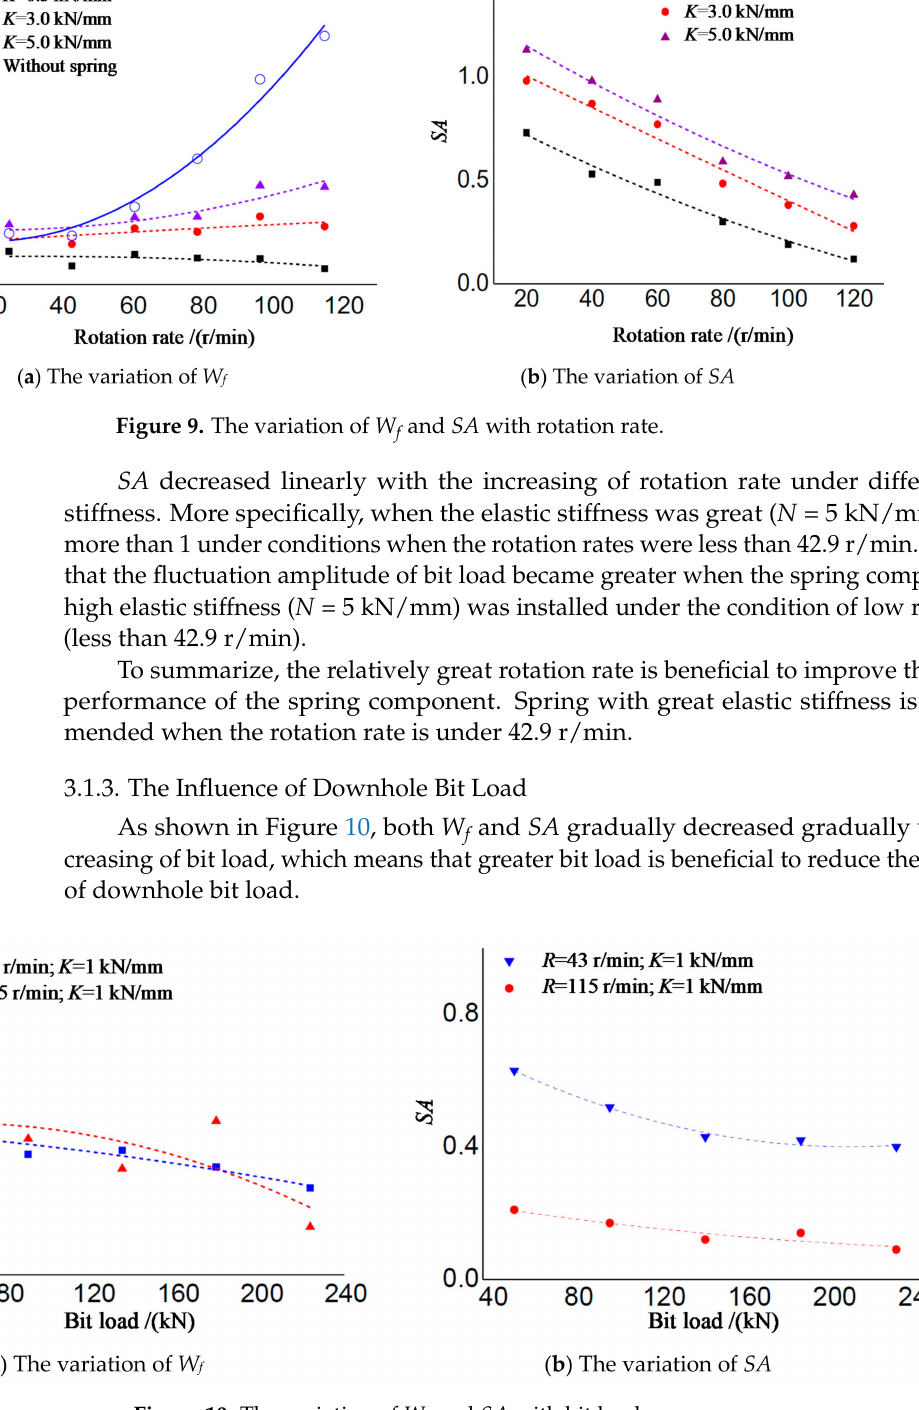
Figure 10. The variation of W f and SA with bit